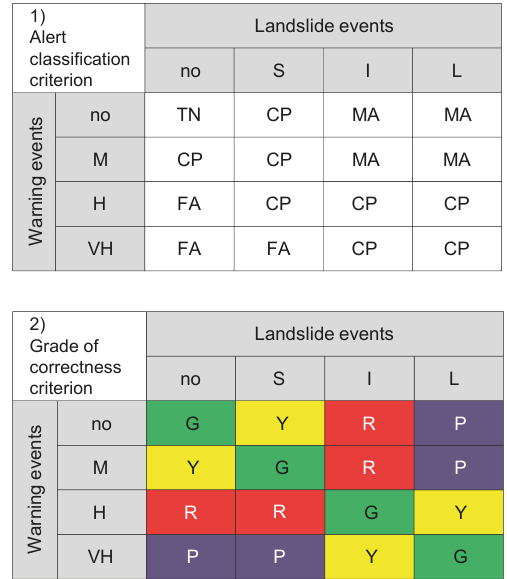
Figure 3. Performance criteria used for the analyses performed herein (modified from Calvello and Piciullo, 2016). Four